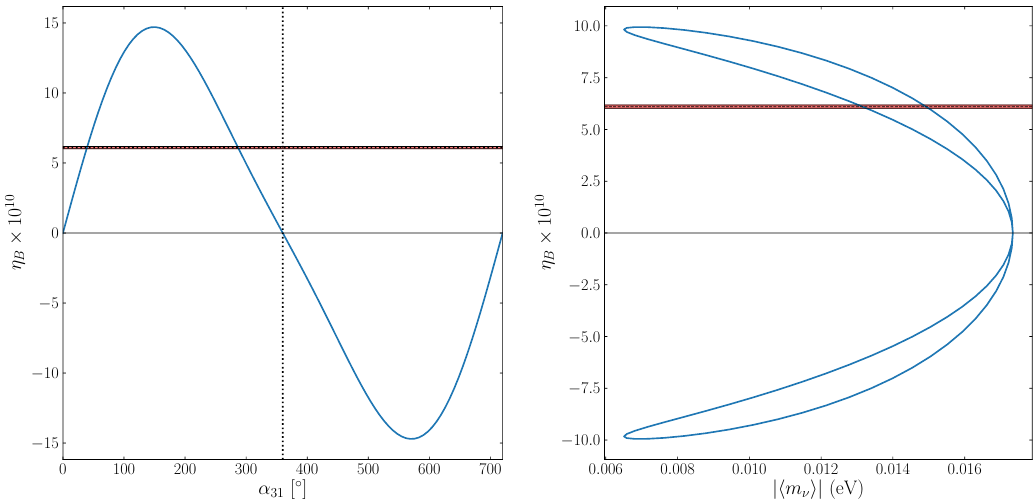
Figure 17 . High-scale leptogenesis ( M 1 = 3 : 16 10 13 GeV) with CP violation is provided solely (cid:2) by (cid:11) 31 , with (cid:14) = 0 (cid:14) , (cid:11) 21 = 0 (cid:14) . The red bands indicate the 1 (cid:27) observed values for (cid:17) B with the best-(cid:12)t value indicated by the horizontal black dotted lines. Left: the baryon asymmetry as a function of (cid:11) 31 , with exact CP -invariance when (cid:11) 31 = 0 (cid:14) and 360 (cid:14) (vertical black dotted lines). Right: the parametric plot of (cid:17) B against the e(cid:11)ective neutrino Majorana mass as m (cid:23) jh ij (cid:11) 31 is varied. At the values (cid:11) 31 = 17 (cid:14) ; 43 (cid:14) , (cid:17) B takes on its observed values corresponding